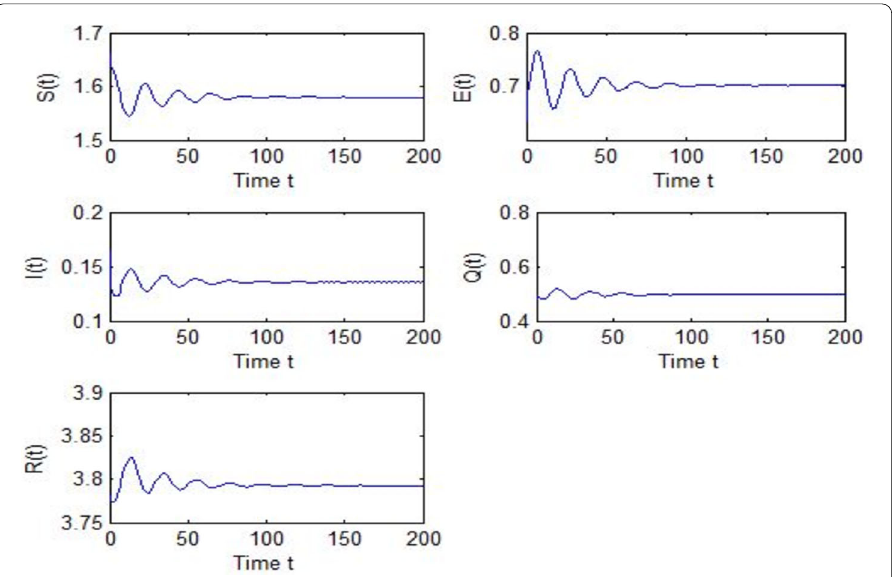
Figure 1 Evolutions of S , E , I , Q , R for τ 1 = 6.037 < τ 10 along with time